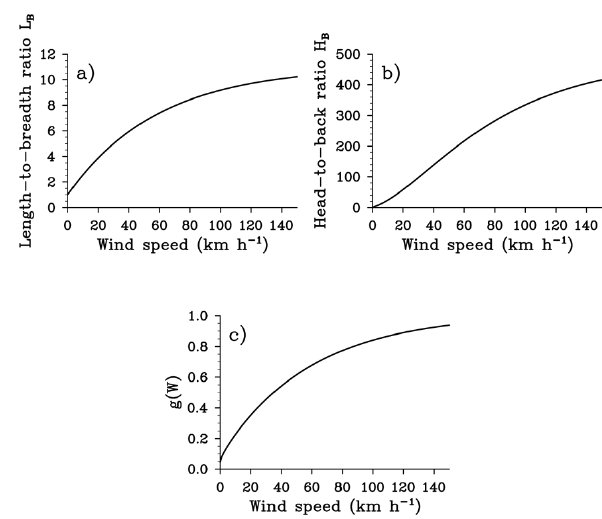
Fig. 6. (a) Length-to-breadth ratio L B , (b) head-to-back ratio H B , and (c) dependence of fire spread rate in the downwind direction on wind speed g(W) as functions of wind